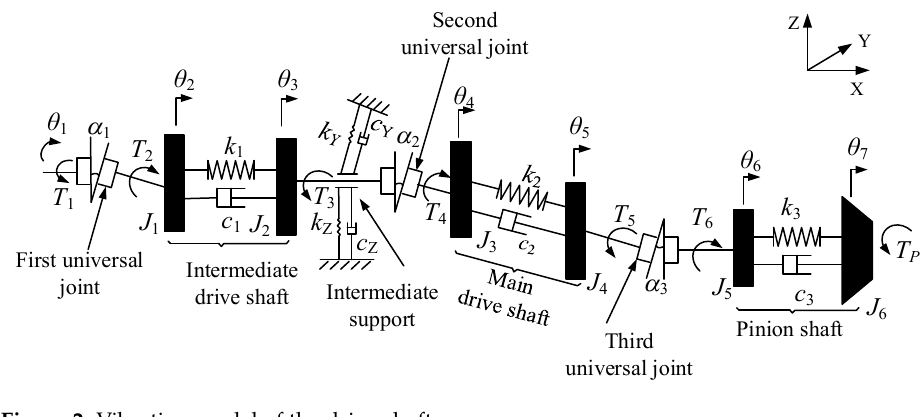
Figure 2. Vibration model of the drive shaft.